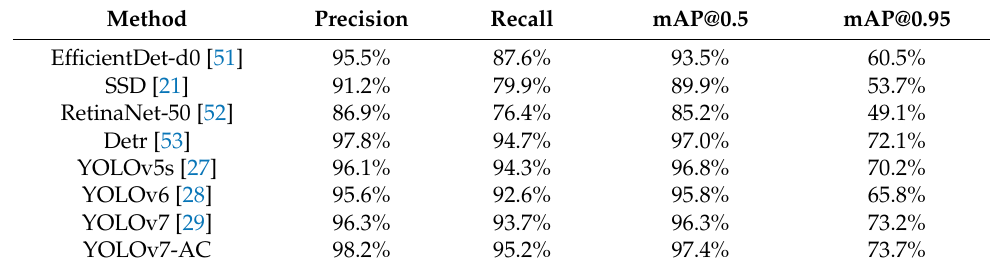
Table 6. Performance comparison of target detection model on the Brackish dataset.